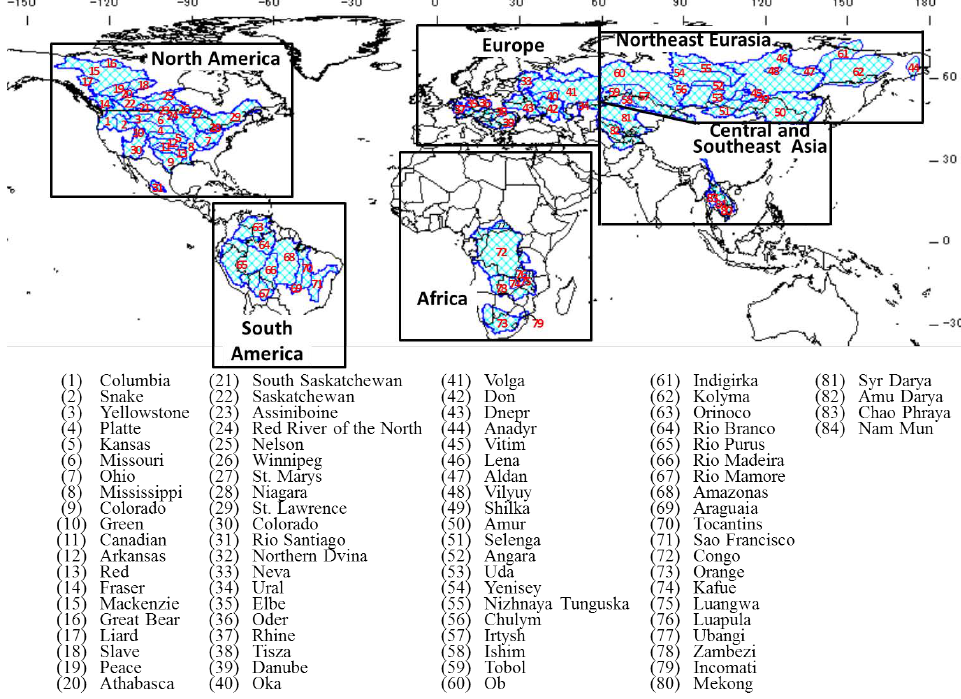
Fig. 1. Eighty-four river basins selected to evaluate future reductions in fish species richness. Basin map with locations of the 84 individual river basins indicated by